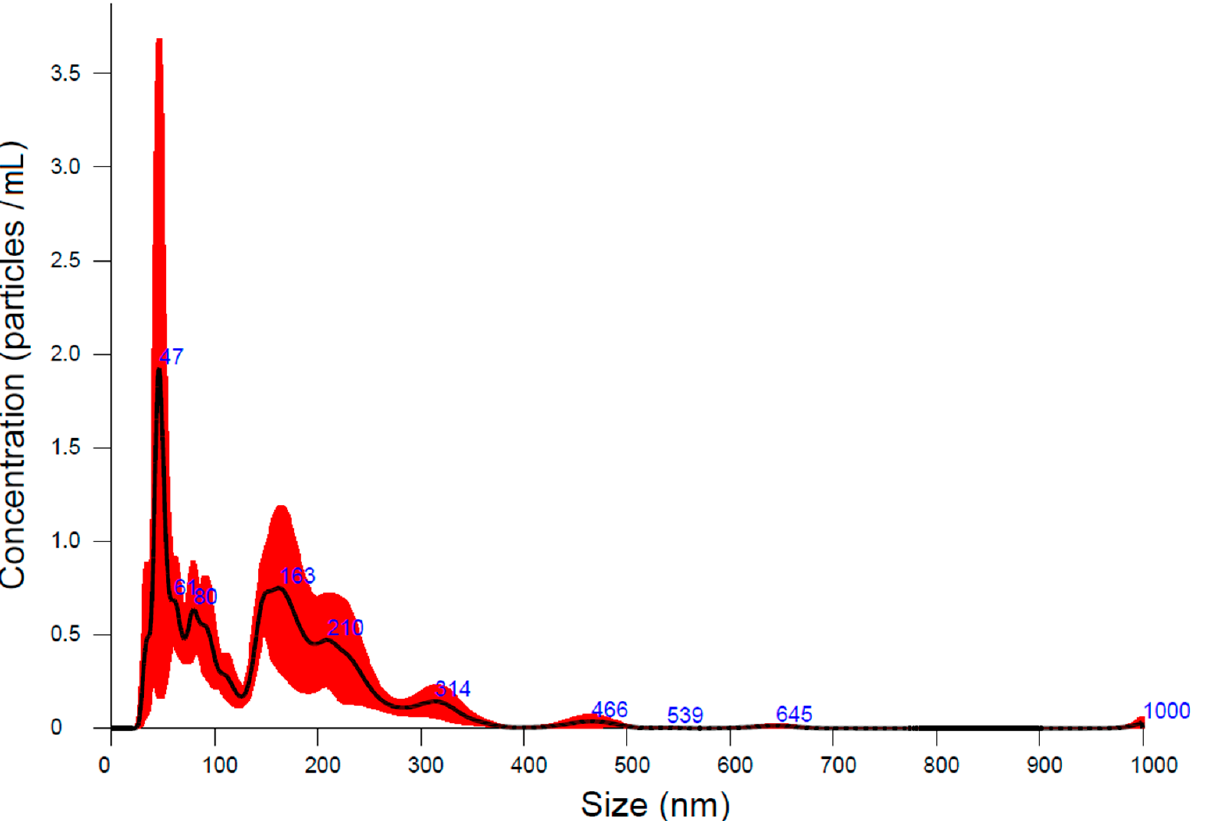
Figure 11. NTA results for A-IONPs dimensional distribution.